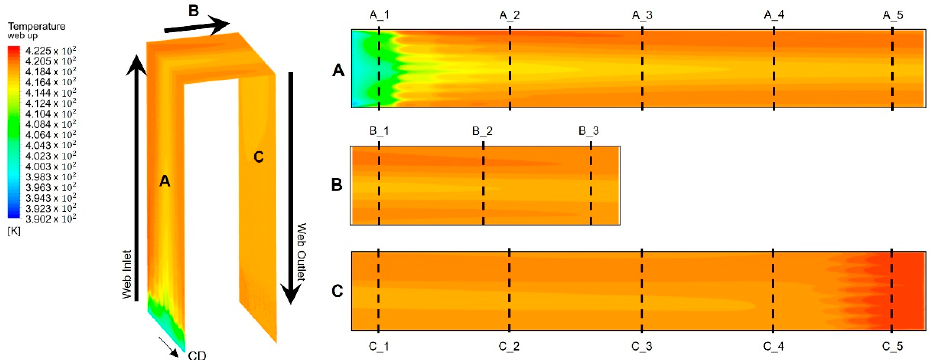
Figure 8. Temperature distribution of the web at Regions A, B, and C in the dryer. Table 3. Standard deviations of the web temperature distribution in the dryer Region